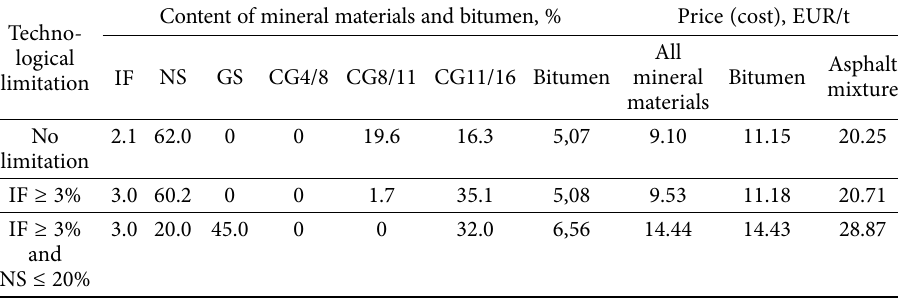
Table 7. The minimal cost of the mineral part, bitumen and asphalt mixture